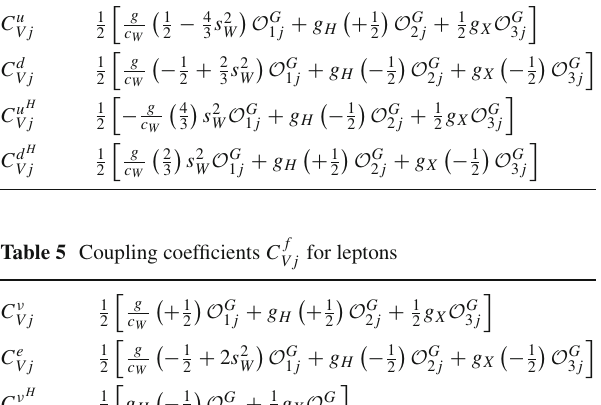
Table 4 Coupling coefficients C f